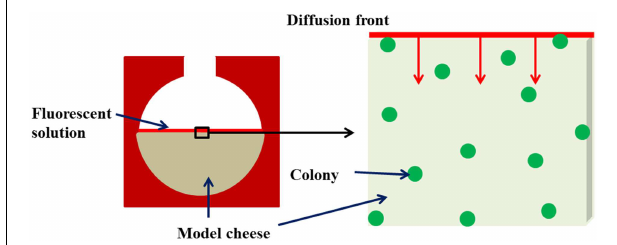
FIGURE 1 | Diagram of the experimental device for monitoring the kinetics of diffusion of solutes around and inside colonies immobilized in the model